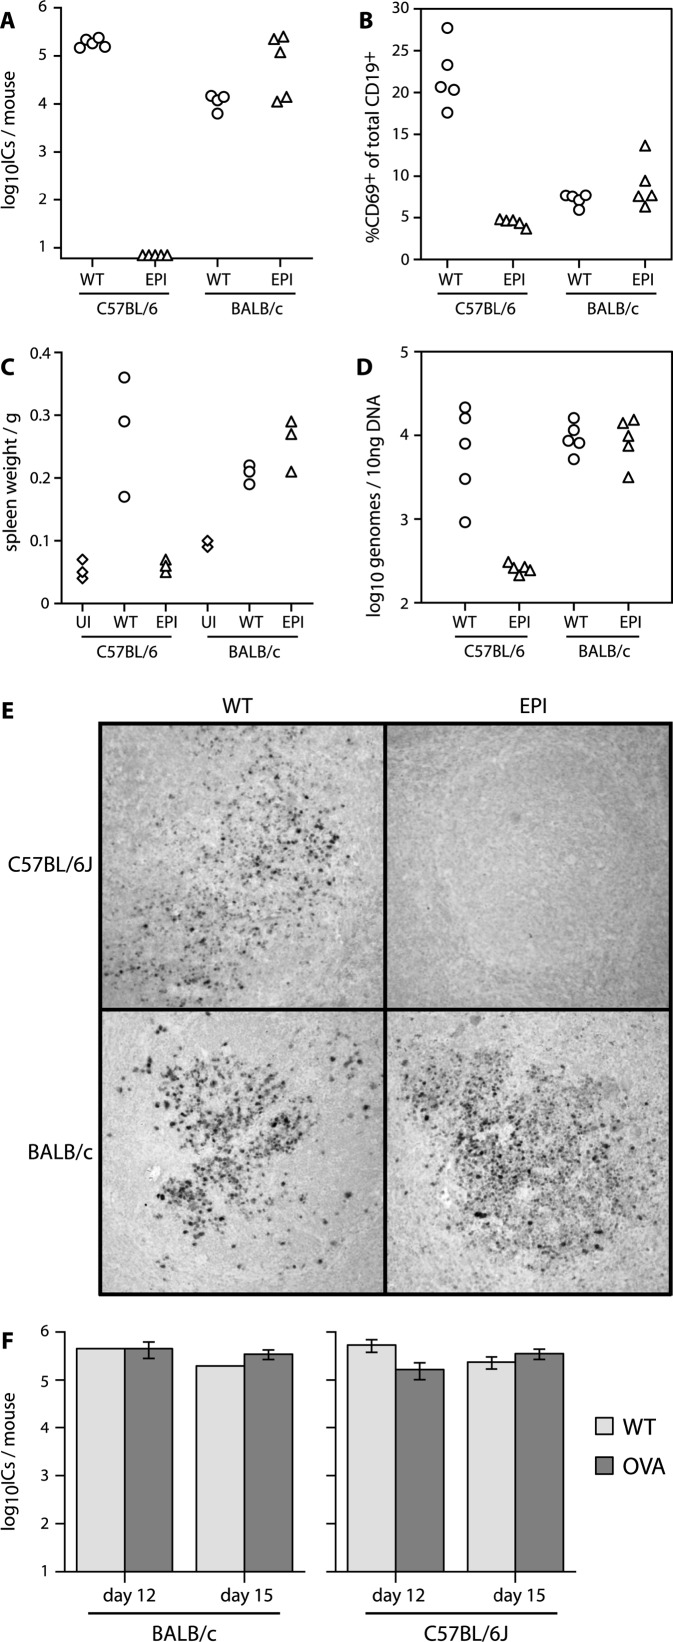
Normal EPI Virus Replication in Non-H2b Mice(A) Infectious centre titres in individual spleens were determined 14 d after intranasal infection of C57BL/6J (H2b) or BALB/c (H2d) mice with WT or EPI virus.(B) CD69 expression on splenic B cells was measured by flow cytometry 14 d post-infection. B cells from uninfected mice were less than 5% CD69+.(C) The weights of individual spleens are shown 14 d post-infection, with spleens of age-matched, uninfected mice (UI) for comparison.(D) Viral genome loads in individual mice were determined by real-time PCR at 14 d post-infection.(E) Viral tRNA expression in infected germinal centres was visualised by in situ hybridization with a digoxigenin-labelled riboprobe specific for tRNAs 1–4. Representative follicles of at least five sections per mouse and three mice per group are shown. tRNA+ follicles were abundant with WT virus and with the EPI virus in BALB/c mice, but were not seen with the EPI virus in C57BL/6J mice.(F) BALB/c or C57BL/6J mice were infected intranasally with MHV-68 expressing OVA from an intergenic expression cassette (OVA) or with WT virus. The extent of lymphoid colonisation was determined by infectious centre assay of spleens 12 and 15 d post-infection. Mean ± SEM titres of five mice per group are shown. In contrast to the EPI virus, the OVA virus showed no defect in host colonisation.